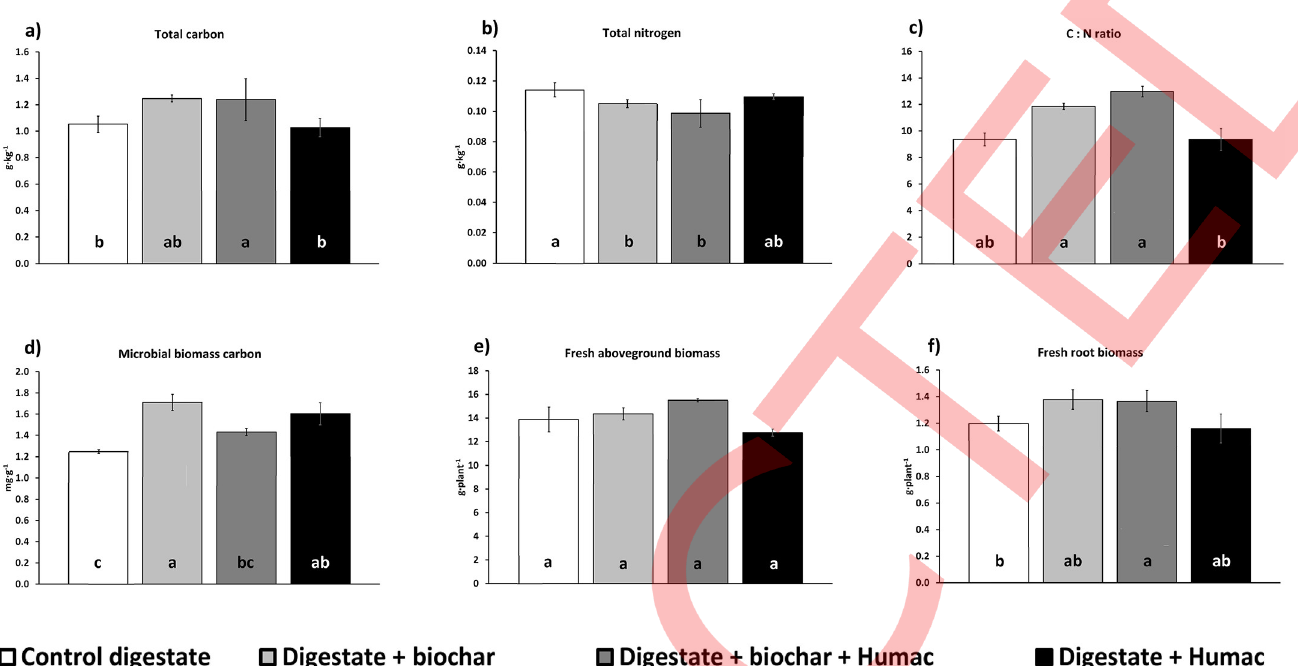
Fig 2. a-f Total soil carbon (a) and nitrogen (b) , C:N ratio (c) , microbial biomass carbon (d) , fresh above-ground (b) and root biomass (f) mean values with a confidence interval of 95% (error bars). Different letters indicate statistically significant differences in MANOVA at p � 0.05.